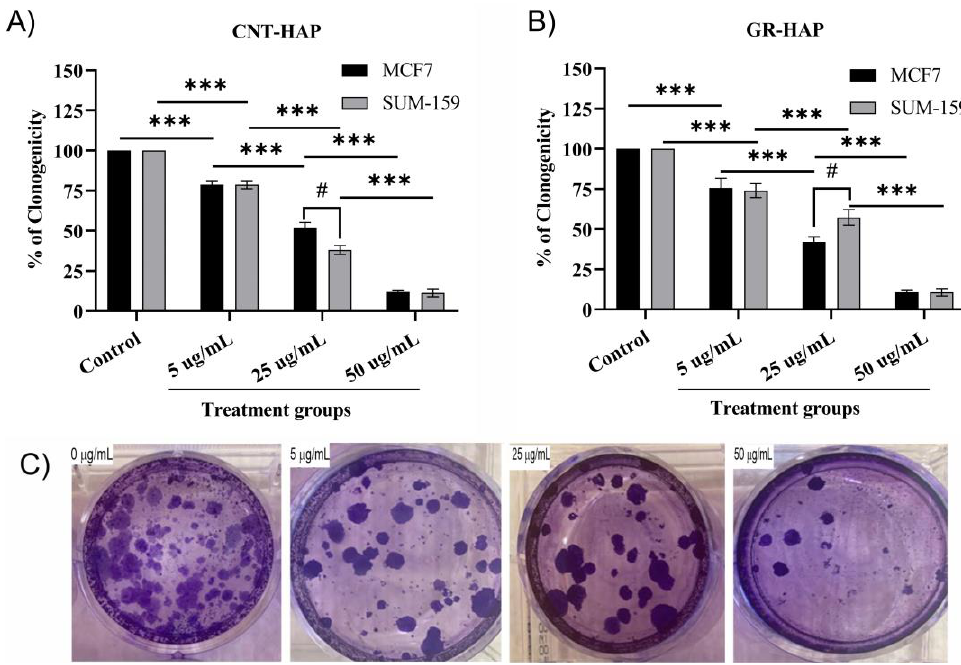
Figure 5. CNT-HAP and GR-HAP dose-dependently inhibited the clonogenicity of MCF7 and SUM-159 breast cancer cells. ( A ) Clonogenic analysis of breast cancer cells after CNTs-HAP treatment. The MCF7 and SUM-159 cells were treated with the indicated concentration of CNTs-HAP, tryp- sinized, and plated at low density (2000 per well in 6-well plates). ( B ) Clonogenic analysis of breast cancer cells after GR-HAP treatment. MCF7 and SUM-159 cell was treated with the indicated con- centration of GR-HAP, trypsinized, and plated at low density (2000 per well in 6-well plates). After two weeks, formed colonies were stained with crystal violet. Clones in a given area were counted for each condition. Columns, mean of three independent determinations; bars, SD. C) After two weeks of treating the SUM- 159 cell with 0, 5, 25, and 50 μg/mL of GR -HAP, trypsinized and plated at low density (2000 per well in 6-well plate). Formed colonies were stained with crystal violet. *** p < 0.001 indicates a significant change in clonogenicity between different treatment groups, whereas # p < 0.05 indicates a significant difference between the two cell lines . 3.2.3. Wound-Healing Assay The wound-healing ability of the cells following CNT-HAP and GR-HAP treatment was evaluated to assess the migration inhibitory potential of the investigated nanomateri- als, and the outcomes are summarized in Figure 6. The GR-HAP demonstrated a substan- tial inhibitory effect on the cell motility of both MCF-7 and SUM-159 cell lines, whereas the CNT-HAP could not inhibit the cell motility comparatively (Figure 6). Figure 6 shows that, in particular, at 25 μg/mL, GR -HAP inhibited cell motility of SUM-159 cells effi- ciently.